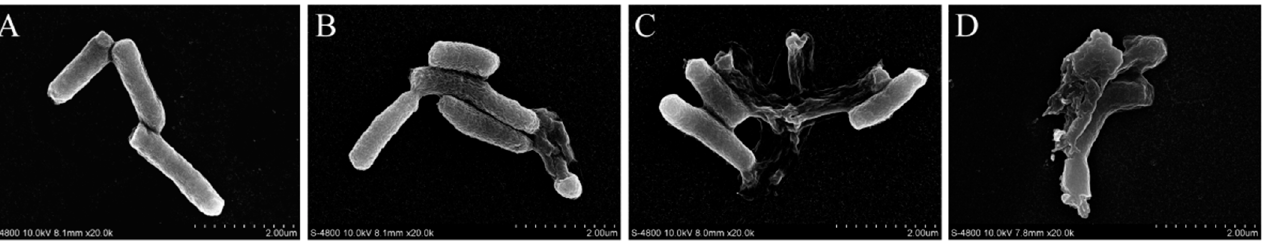
Figure 2. Scanning electron micrographs of Vibrio parahaemolyticus. ( A ) Untreated, ( B ) treated with 405 nm LED irradiation for 10 min, ( C ) treated with 0.1 mg/mL of citral for 10 min, and ( D ) LED treatment combined with 0.1 mg/mL of citral for 10 min.